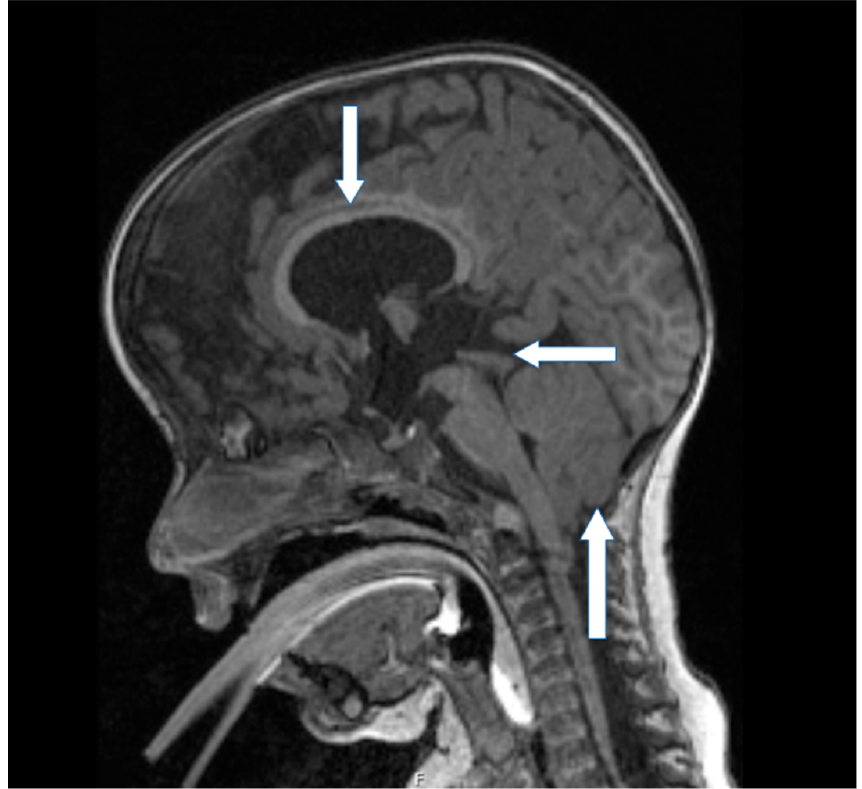
Figure 2. Non-enhanced sagittal MRI T1-weighted scan revealed a Chiari malformation type 2 (up arrow), hypoplasia of the corpus callosum (down arrow), and dysgenesis of the lamina tecti (left arrow).